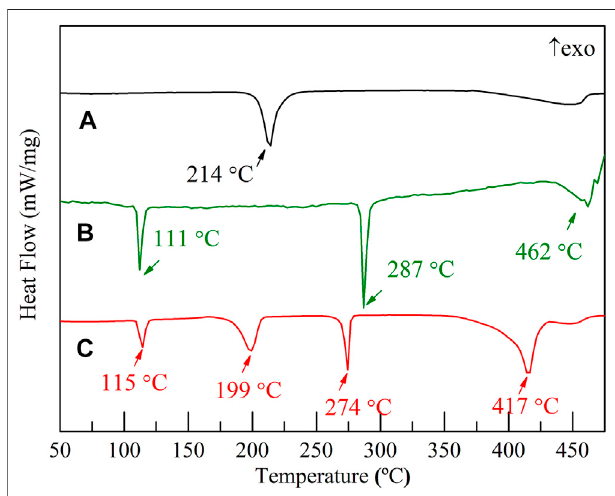
FIGURE 1 | DSC traces of (A) Li 3 AlH 6 , (B) LiBH 4 , and (C) 2LiBH 4 – Li 3 AlH 6 composite.